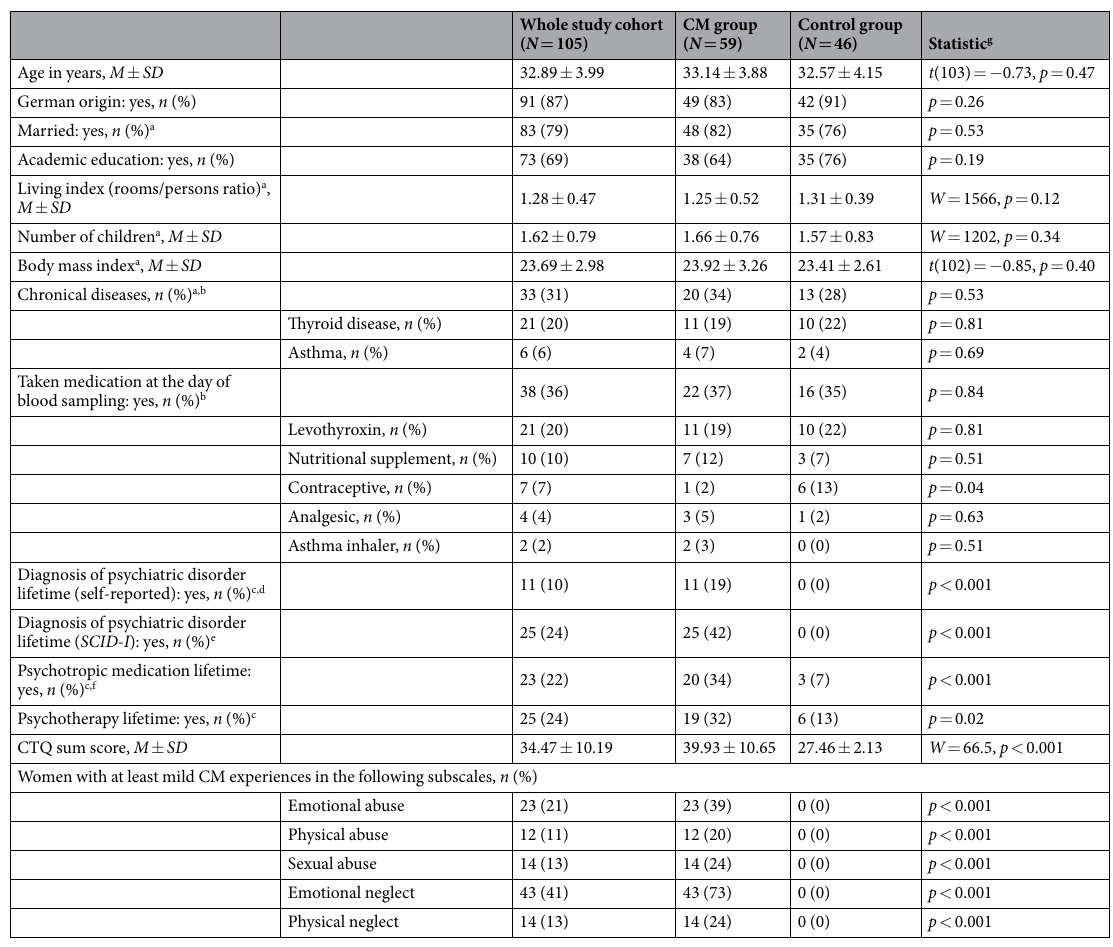
Table 1. Demographic and clinical characteristics of women with and without childhood maltreatment history. CM = childhood maltreatment; CTQ = Childhood Trauma Questionnaire 23,24 ; SCID-I = Structured Clinical Interview 55 . a Missing data for one woman of the CM group. b Only chronical diseases or taken medication with more than one occurrence are displayed. c Missing data for two women of the CM group. d Self-reported lifetime psychiatric diagnoses: major depressive disorder (MDD; N = 4), anxiety disorders ( N = 3), other diagnoses with one occurrence each (anorexia, adjustment disorder; comorbid: bulimia & PTSD, anxiety disorder & MDD). e In SCID-I interview diagnosed lifetime psychiatric diagnoses according to DSM5 criteria: MDD ( N = 4), anxiety disorders ( N = 11), alcohol use disorder ( N = 2); comorbid diagnoses: MDD & anxiety disorder ( N = 2), MDD & PTSD & anxiety disorder ( N = 2), MDD & PTSD ( N = 1), MDD & alcohol use disorder ( N = 1), MDD & stimulant use disorder ( N = 1), MDD & social phobia & obsessive-compulsive disorder ( N = 1). f Lifetime psychotropic medication with more than one occurrence: Hypericum perforatum ( N = 7 in CM group), Valeriana ( N = 3 in CM group), Lorazepam ( N = 3 in CM group, N = 1 in control group). g For